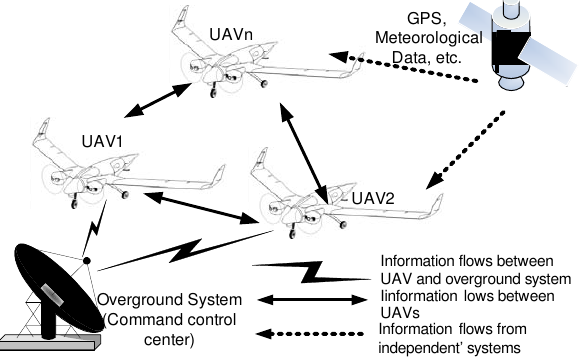
Fig 1. Review of information flows between different systems (Goraj 2007) Communication systems are classified into two groups: